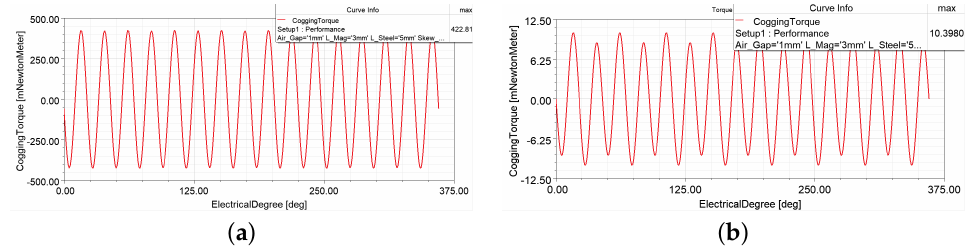
Figure 4. Cogging torque ( a ) for the motor without skewing and ( b ) for the motor with a skew percentage of 0.12.